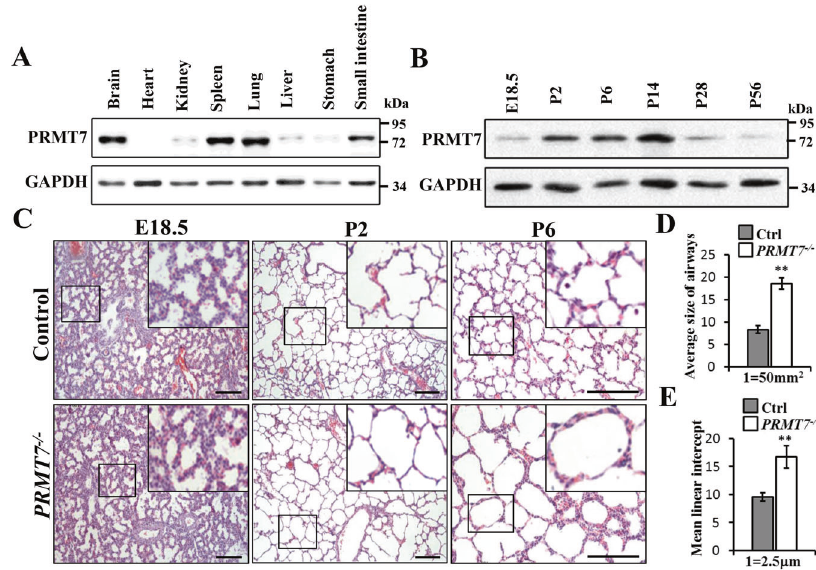
Fig. 1 Impaired alveolarization in PRMT7 − / − lungs. A Western blot analysis showing the boundary expressed PRMT7 in lung tissues. B PRMT7 expression was signi fi cantly increased in lung tissues during P2 to P14. For ( A ) and ( B ), GAPDH serves as a loading control. The experiment was repeated three times with similar results. C Representative hematoxylin and eosin (H&E) staining showing severely enlarged alveolar airspace in PRMT7 − / − lungs at P2 and day P6. Boxed regions are magni fi ed in insets. Scale bars: 100 μ m. D , E Quantitated bar graphs showing the average size of distal airways ( D ) and the mean linear intercept ( E ), which describes the mean free distance in airspaces, was signi fi cantly larger in PRMT7 − / − lungs. Data were presented as mean ± SD. n = 8 mice per genotype. ** P < 0.01 (Student ’ s t